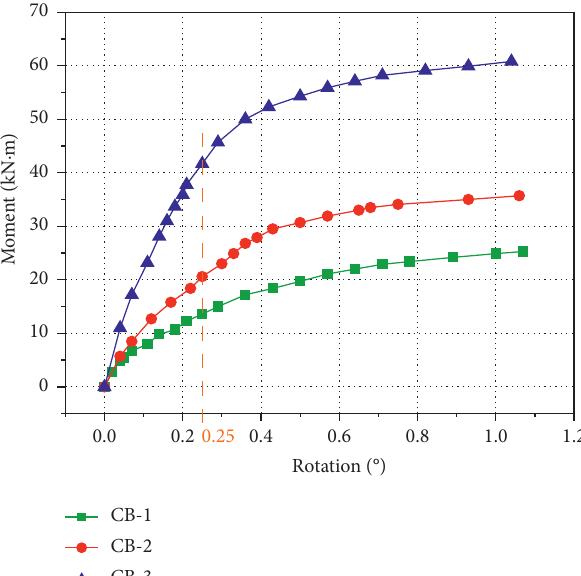
Figure 7: Moment-rotation curves.